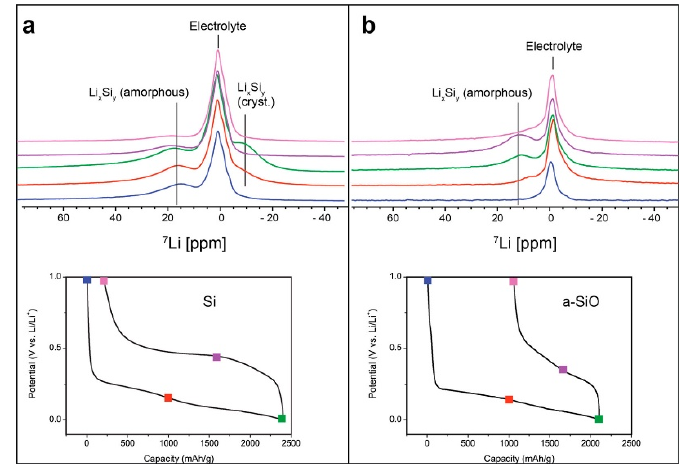
Figure 6. Comparison of 7 Li in situ snapshots detailing changes in the Li chemical shift for cellulose-based silicon metal anodes ( a ) and a-SiO ( b ). (Reproduced with permission from [66]; Copyright 2019 American Chemical Society.